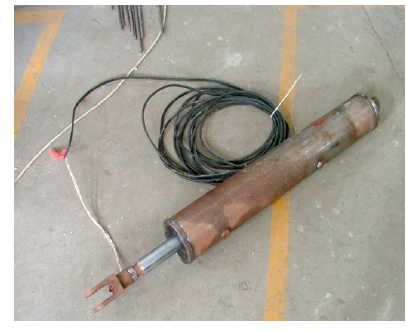
Figure 5. MR damper.